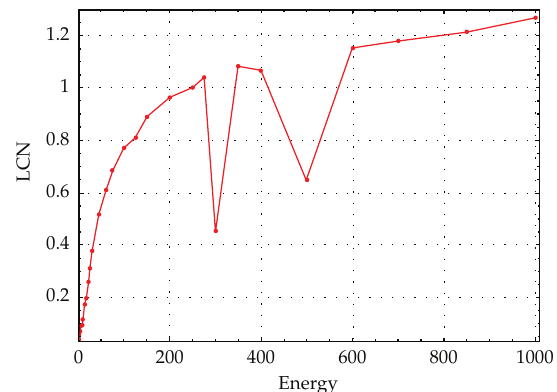
Figure 9: LCN versus Energy in sixth-order